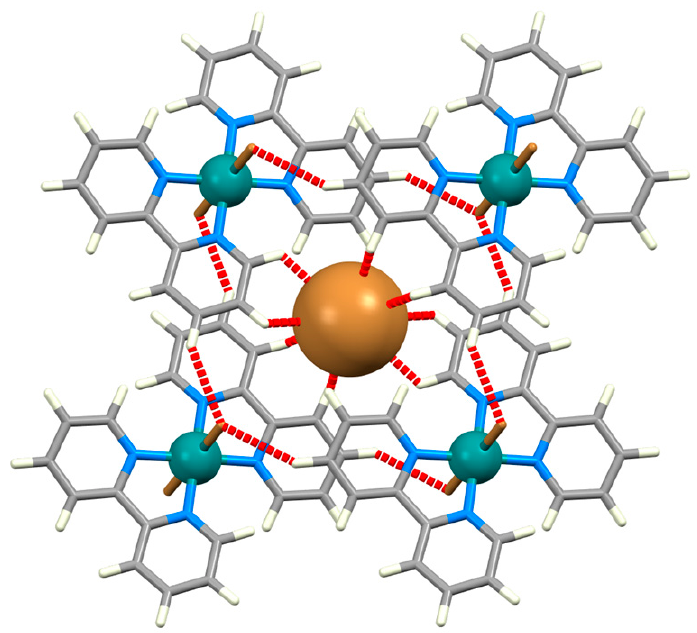
Table 1. Parameters for CH bpy ...Br − ion contacts in trans- [Ru(bpy) 2 Br 2 ]Br.